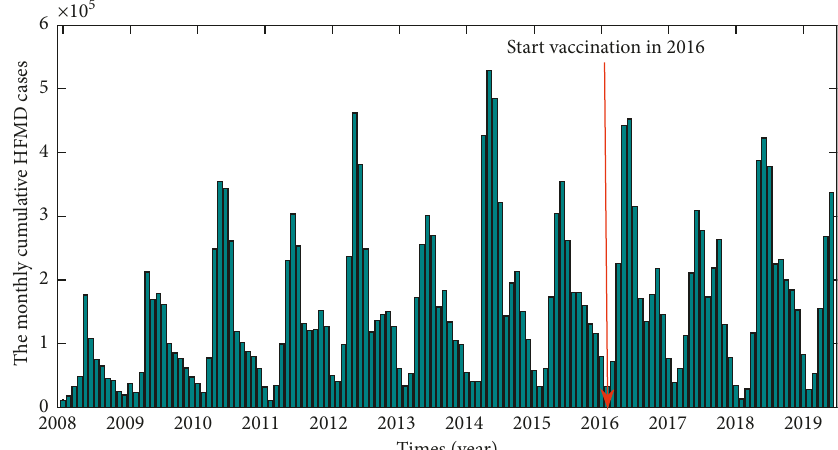
Figure 1: The confirmed monthly cumulative HFMD cases from the Chinese Center for Disease Control and Prevention (CCDC) from January 2008 to June